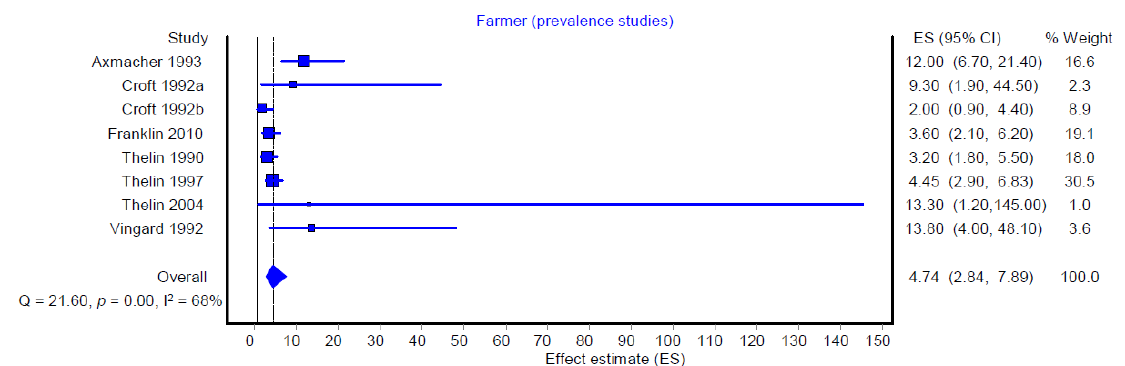
Figure 4. Meta-analysis of the risk of hip osteoarthritis among farmers in prevalence studies (all prevalence studies, n = 8).